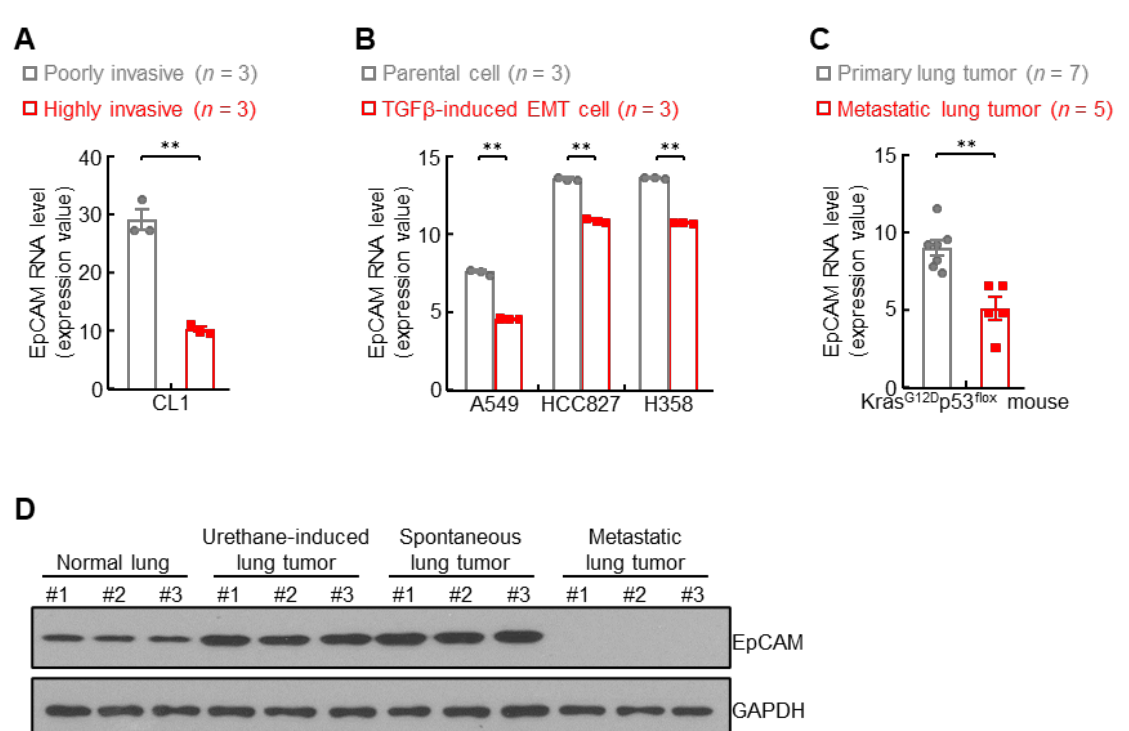
Figure 4. EpCAM expression is downregulated in metastatic lung cancer. ( A ) GSE42407 data showing decreased EpCAM RNA expression in highly invasive human lung cancer cell CL1. ( B ) GSE49644 data showing decreased EpCAM RNA expression in TGFβ -induced EMT cells. ( C ) GDS4402 data showing decreased EpCAM RNA expression in lung cancer cells derived from metastatic lung tumors compared to primary lung tumors from Kras G12D p53 flox mice. ( D ) Western blot data showing decreased EpCAM protein expression in breast metastatic lung tumor from FVBN mice. Data are representative of three independent experiments with similar results ( D ). Student’s t test (two-tailed, unpaired) was performed. Data represent means ± SEM ( A – C ). ** p < 0.01. In addition, low EpCAM protein levels were found in highly metastatic human lung cancer cells, including A549, Calu-6, H727, and H460 (Figure 5A), but high in poorly met- astatic lung cancer cells, including H1650, H1975, H3255, and HCC827 (Figure S3). Con- sistently, minimal or no expression of EpCAM RNA and protein was detected in highly metastatic murine lung cancer cells, including LLC, MAD109, and LAP0297 (Figure 5B– D). Taken together, these data suggest that, similar to metastatic lung tumors, EpCAM expression is also repressed in highly metastatic lung cancer cells.